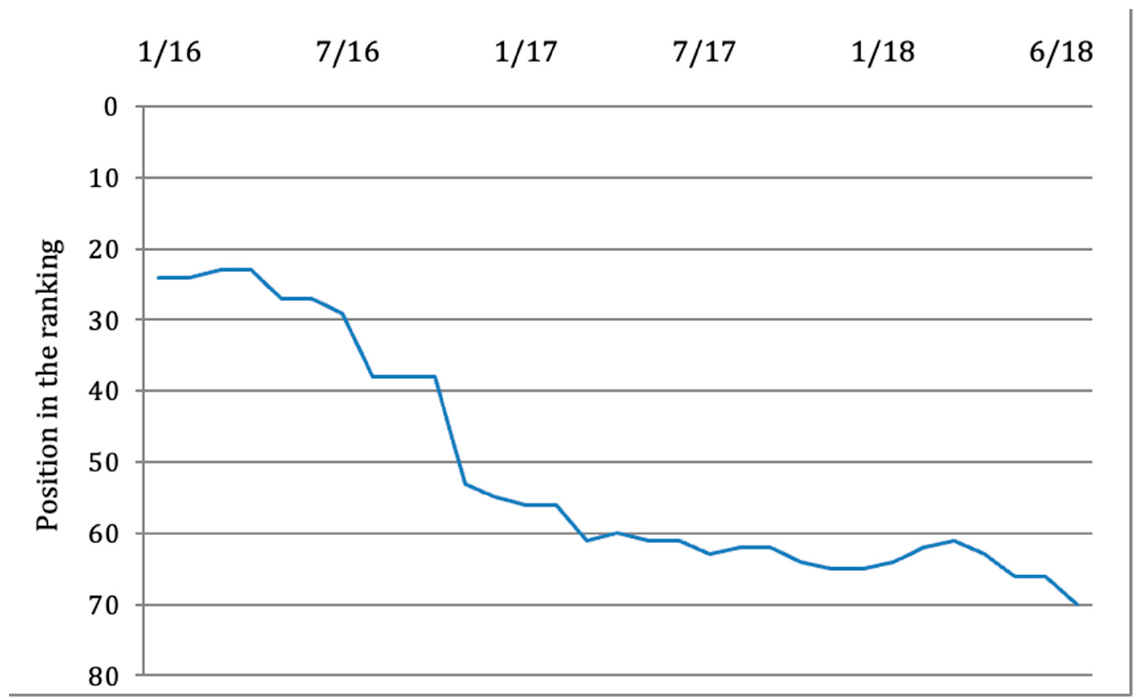
Figure 1. Russia’s downturn in FIFA rankings in the 30 months prior to the 2018 World Cup. Note: Figure illustrates Russia’s position in the FIFA rankings from January 2016 to June 2018. A major slide follows the start of the preliminaries on 4 September 2016.